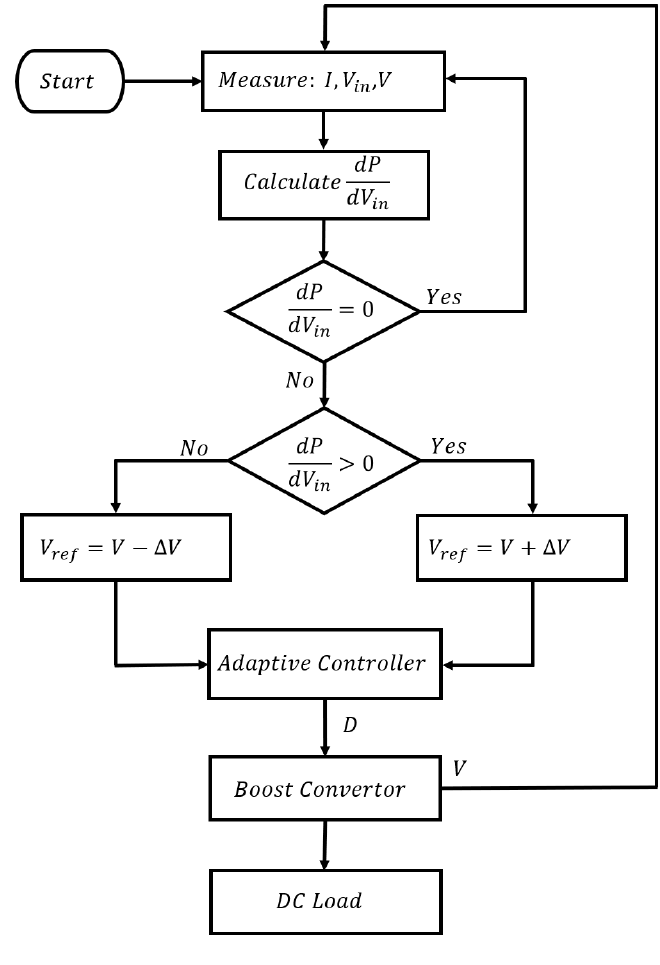
Figure 9. RDAC flowchart.